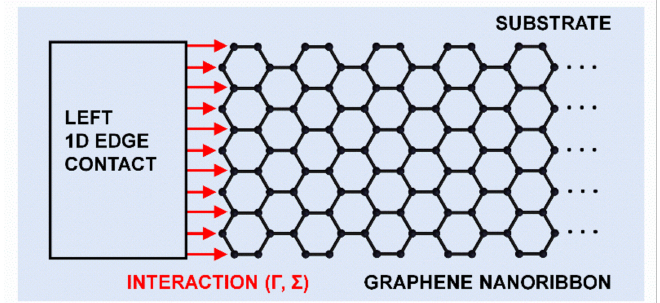
Figure 1. Illustration of the system under study. A graphene nanoribbon is attached to a 1D edge contact that is described with broadening and self-energy within the WBL